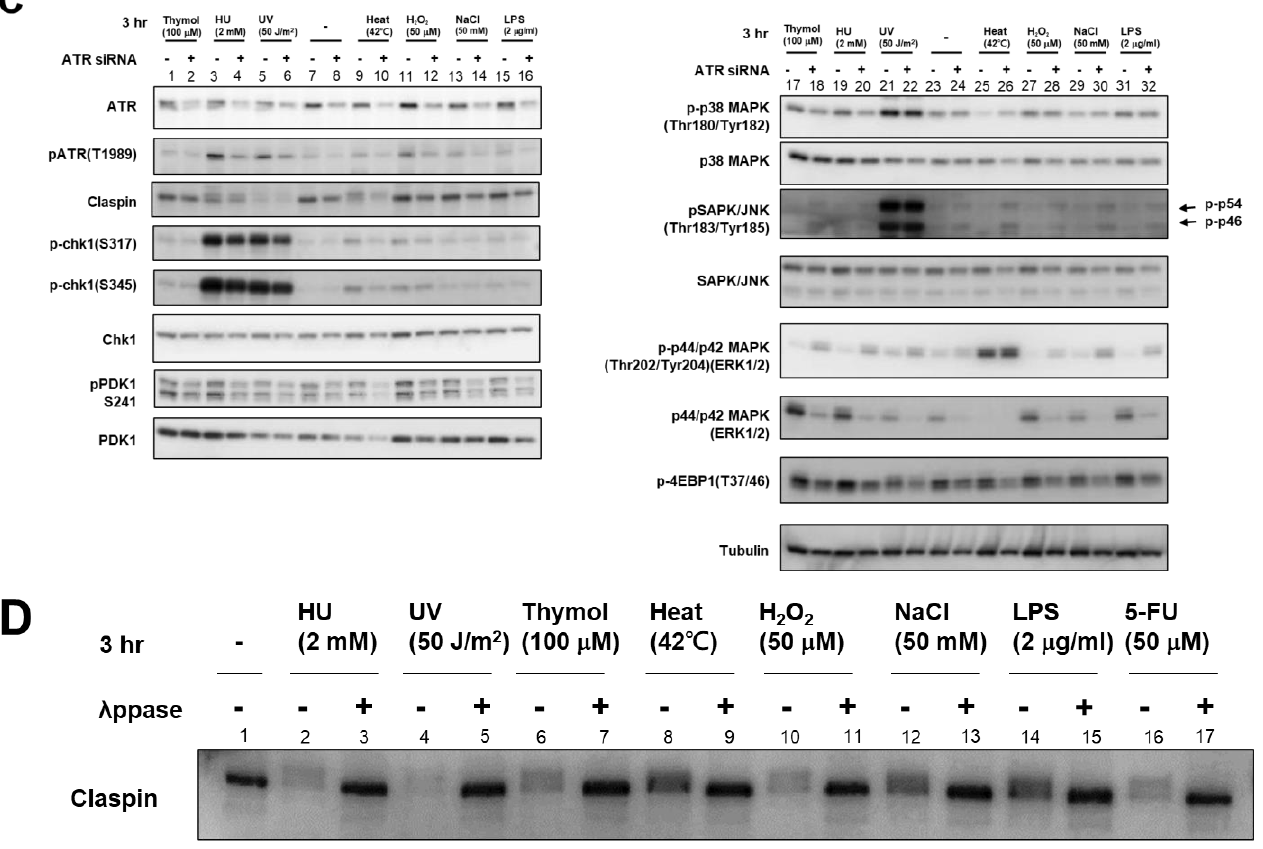
Figure 5. Effects of Claspin or ATR depletion on Chk1 activation by various biological stresses and on the factors involved in growth-related pathways. ( A ) Claspin(f/-) MEF cells were treated with Ad-Cre or nontreated and exposed to various stresses for 3 h. ( B , D ) HeLa cells were transfected with siRNA for Claspin ( B ) or for ATR ( C ), and were exposed to indicated stresses for 3 h before the harvest. The whole cell extracts were analyzed by Western blotting with antibodies indicated. SAPK/JUNK and p38 MAPK (MAPK activated by stresses and growth factors); ERK1/2 (MAPK activated by growth factors and mitogen); 4EBP1 (phosphorylated by mTOR and required for activation of translation); PDK1 (required for activation of mTOR); Mcm2 (phosphorylated by Cdc7 and required for replication); Mcl-1 (anti-apoptotic factor). Phosphorylated forms represent